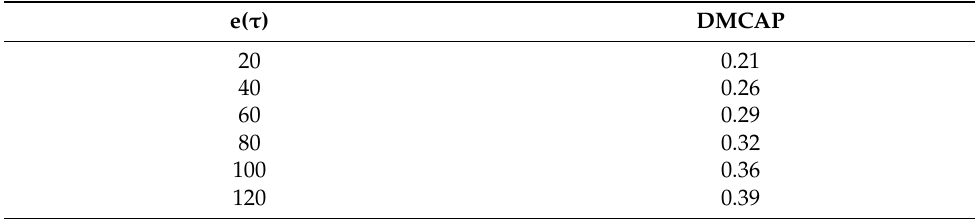
Table 7. Energy optimization